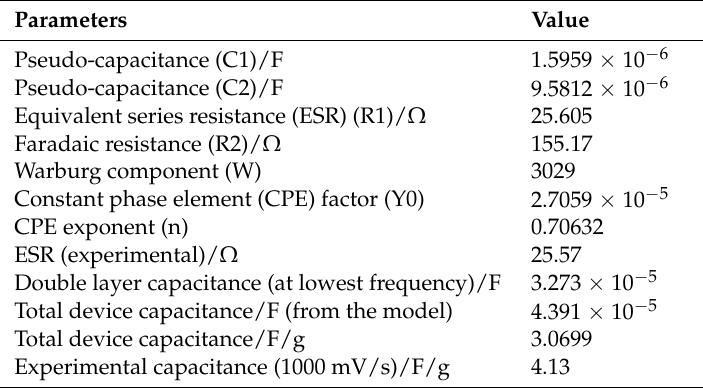
Table 1. The individual circuit component characteristic values prepared from the electrochemical impedance spectroscopy (EIS)